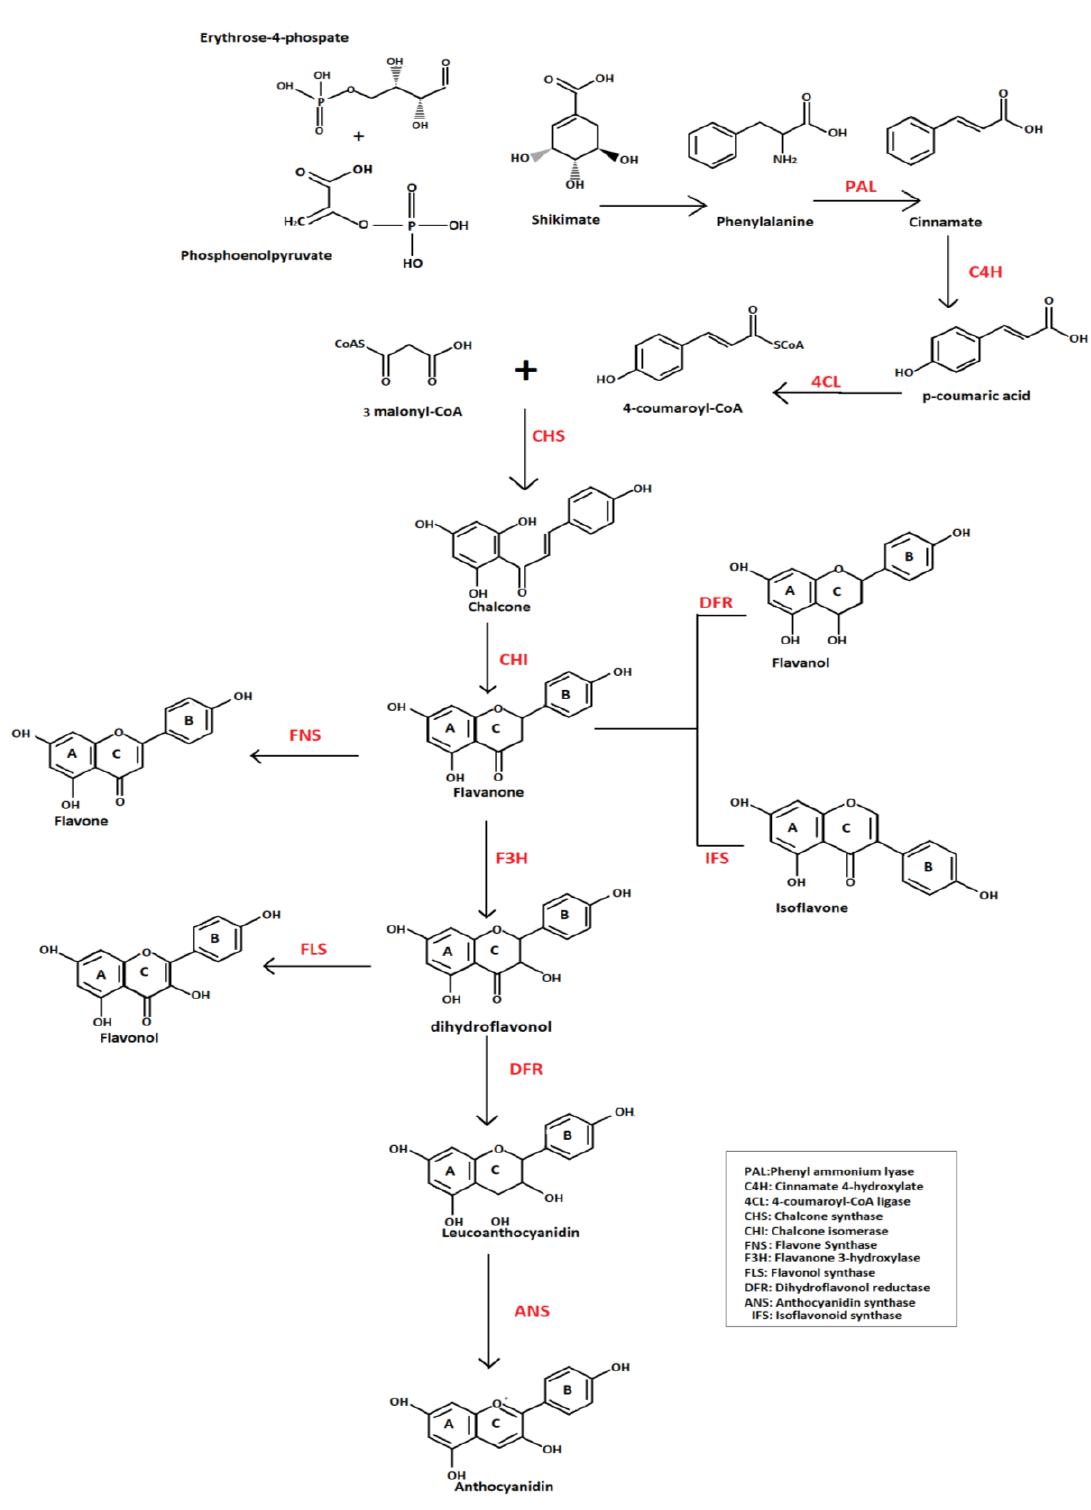
Figure 1. Biosynthesis of flavonoids.